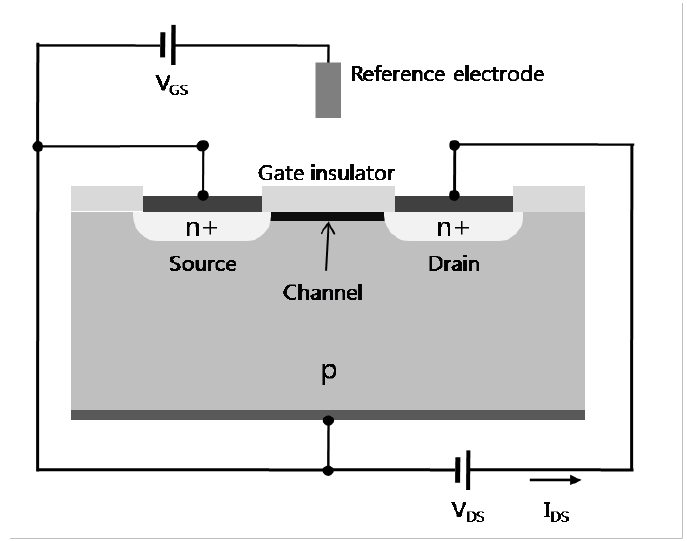
Figure 1. Structure of ISFET. It consists of source, drain, gate insulator, and reference